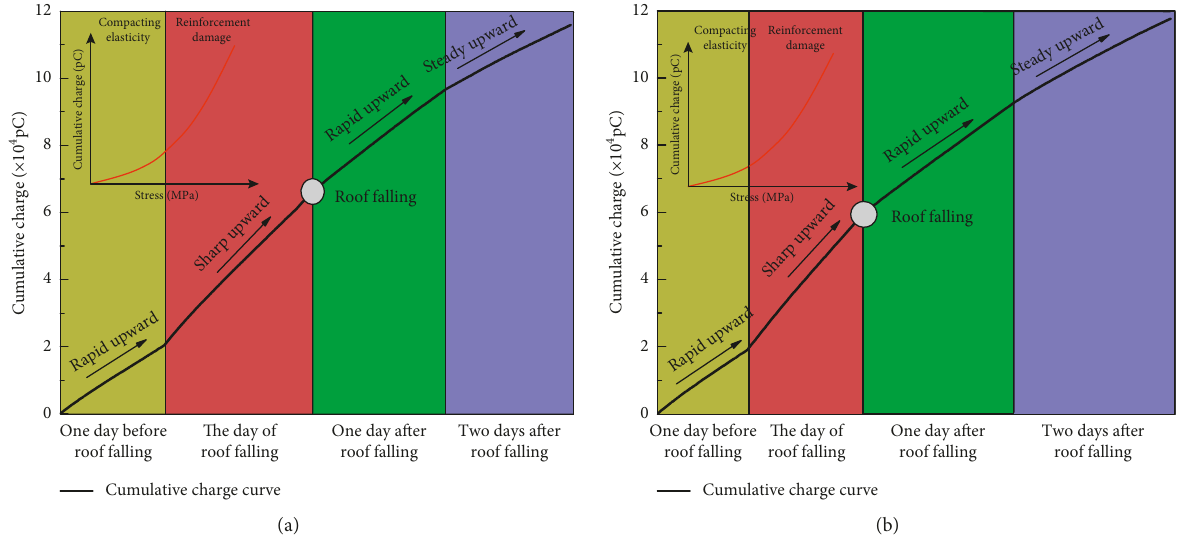
Figure 12: Cumulative charge curve. (a) No. 5 monitoring point. (b) No. 6 monitoring point.